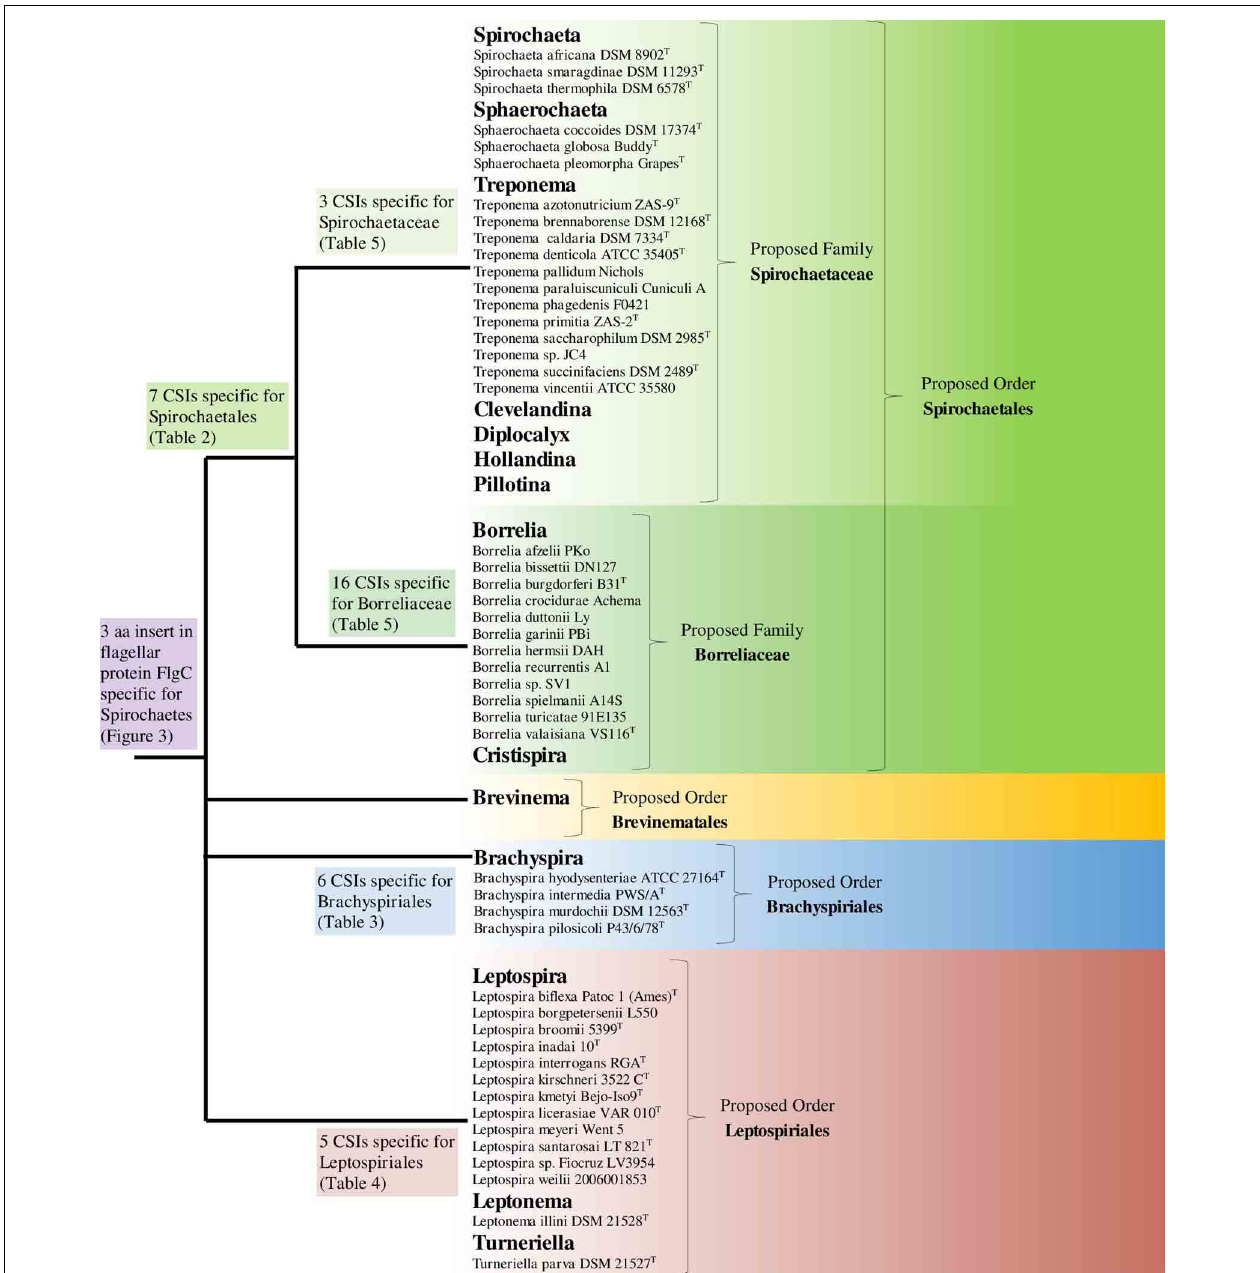
FIGURE 8 | A summary diagram depicting the distribution of identified CSIs and the proposed reclassification of the groups within the phylum Spirochaetes. A representative strain is listed for each genome sequenced species. The letter T refers to the type strain of the